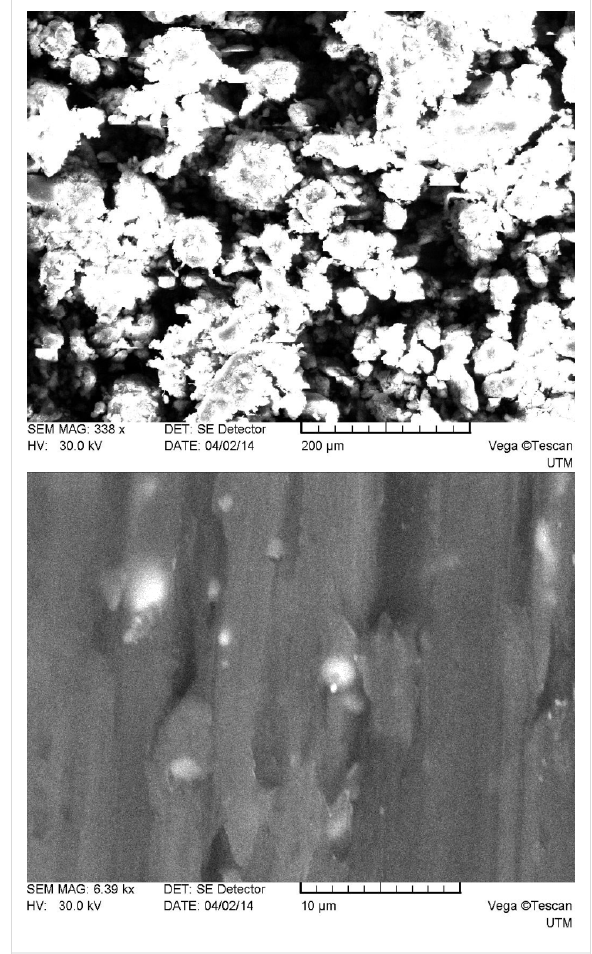
Figure 3: SEM micrographs of system 2 particles (top: magnification 334×, bottom: 5540×).